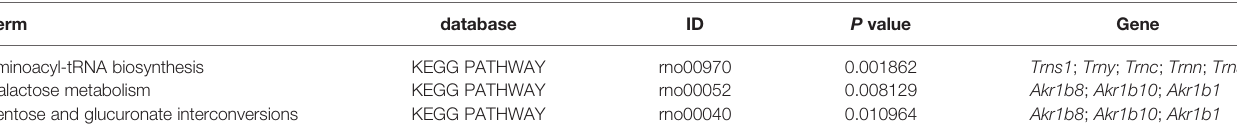
TABLE 2 | The top 3 KEGG pathways involved in W.ISCs and